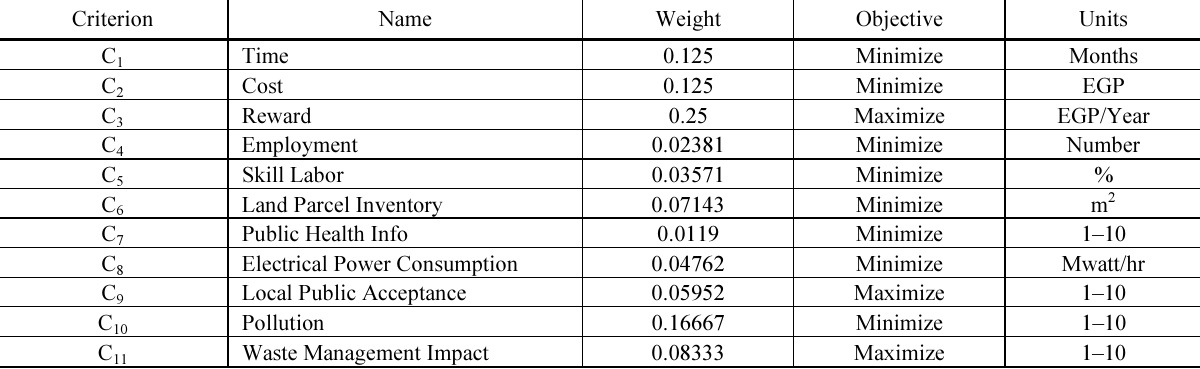
Table 6. Exposition of